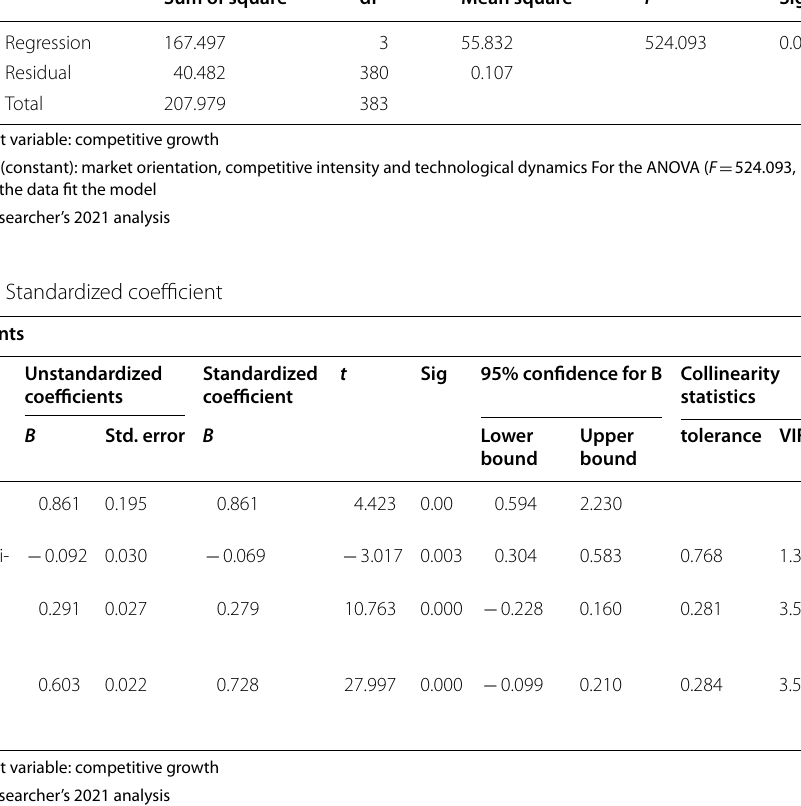
Dependent variable: competitive